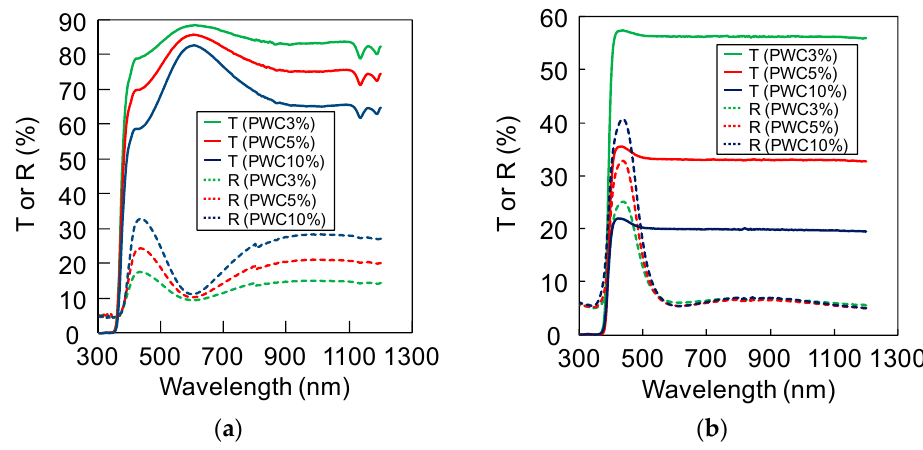
Figure 3. Measured transmittance and reflection of the color layer on the quartz plate as a function of PWC using ( a ) mica pigment and ( b ) OSC pigment.